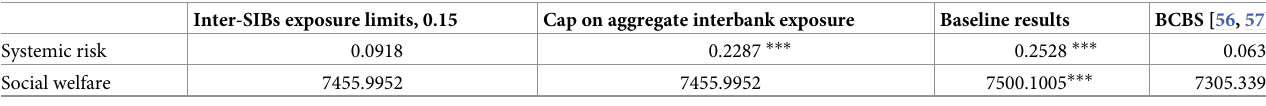
Table 6. Auxiliary statistical results with limits on interbank